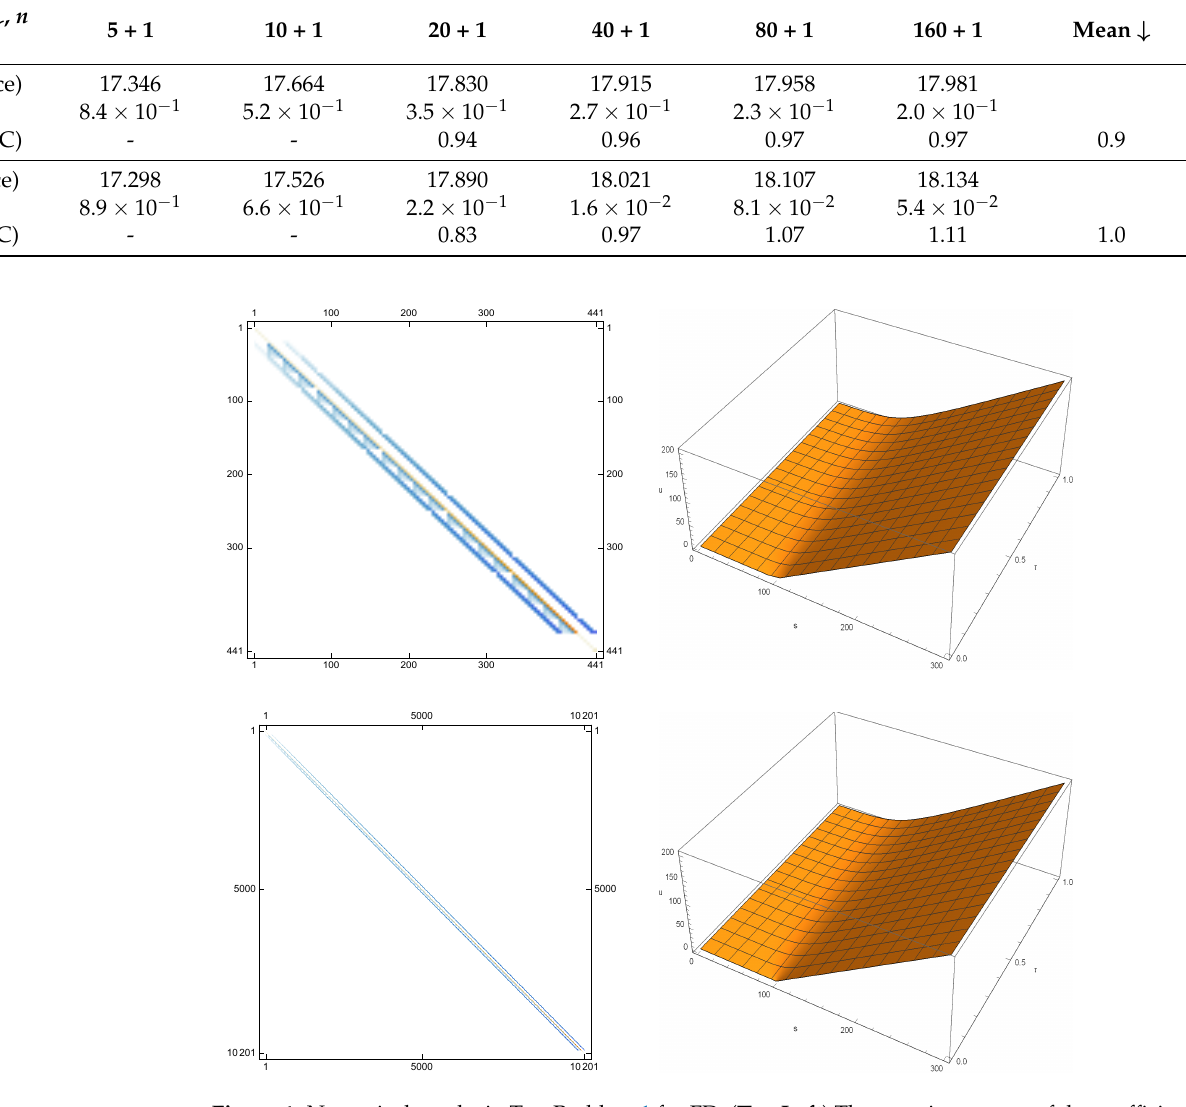
Figure 1. Numerical results in Test Problem 1 for FD. ( Top Left ) The sparsity pattern of the coefficient matrix in (35) based on m = n = 21. ( Top Right ) Time fractional option pricing curve. ( Bottom Left ) The sparsity pattern of the coefficient matrix in (35) based on m = n = 101. ( Bottom Right ) Time fractional option pricing